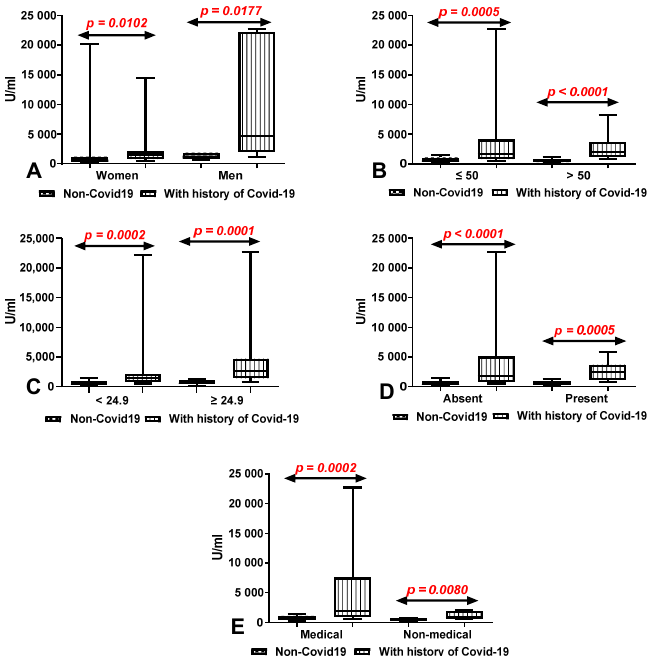
Figure 5. ( A ) Comparison of total anti-SARS-CoV-2 antibody levels in groups of women and men with and without a history of COVID-19. The data are presented as median (minimum-maximum). ( B ) Comparison of total anti-SARS-CoV-2 antibody levels in groups of patients under and over the age of 50 with and without a history of COVID-19. The data are presented as median (minimum- maximum). ( C ) Comparison of total anti-SARS-CoV-2 antibody levels in groups of patients with and without coexisting diseases with and without a history of COVID-19. The data are presented as median (minimum-maximum). ( D ) Comparison of total anti-SARS-CoV-2 antibody levels in groups of medical and non-medical workers with and without a history of COVID-19. The data are pre- sented as median (minimum-maximum). ( E ) Comparison of total anti-SARS-CoV-2 antibody levels between group of patients with normal and increased BMI with and without a history of COVID- 19. The data are presented as median (minimum–maximum).